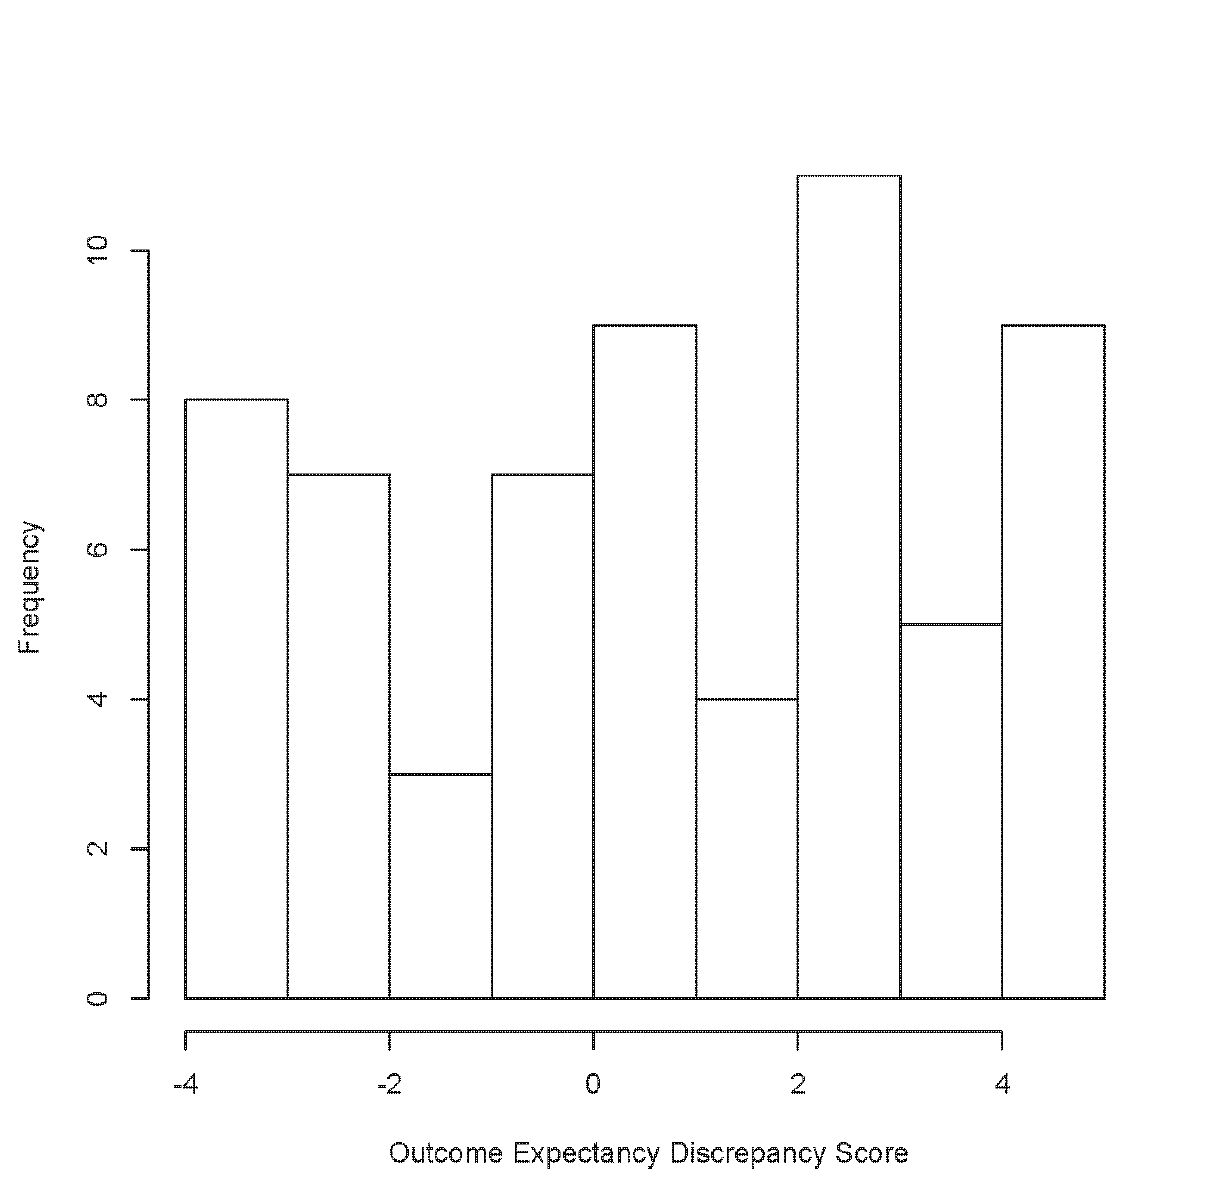
Figure 4. Distribution of outcome expectancy discrepancy